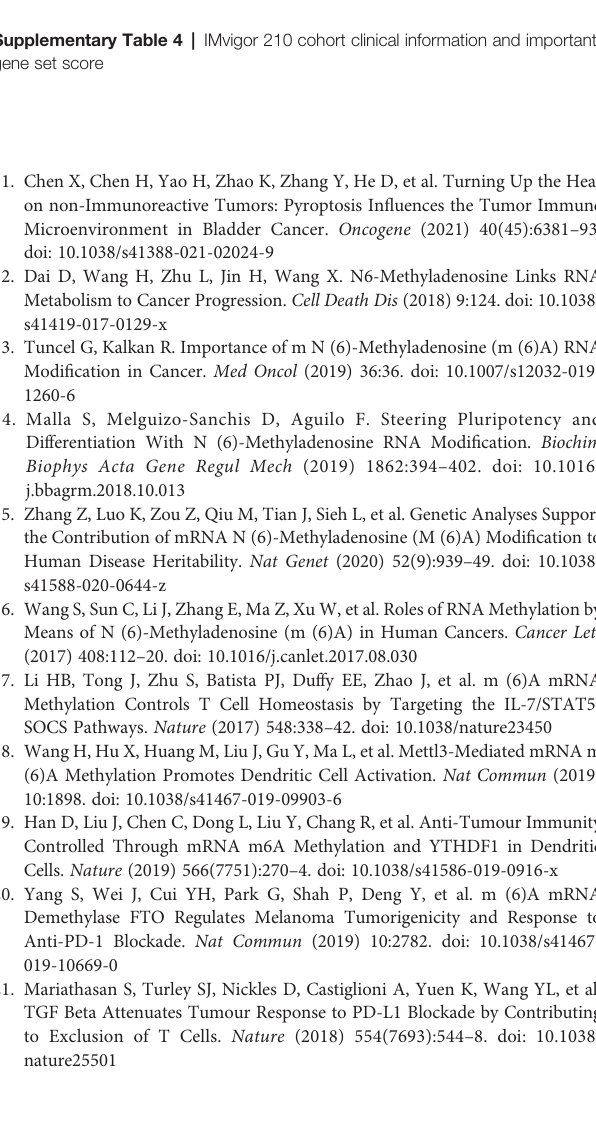
Supplementary Table 1 | Pearson correlation of 23 m 6 A regulatory factors Supplementary Table 2 | Immune cell marker genes Supplementary Table 3 | In fi ltration levels of 28 immune cells and anti-tumor immunity score and pro-tumor immunity scores of 407 samples in the TCGA- BLCA cohort Supplementary Table 4 | IMvigor 210 cohort clinical information and important gene set